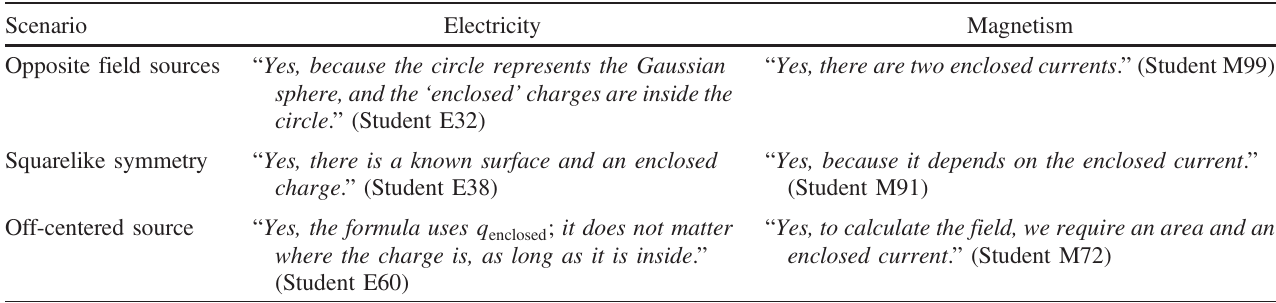
TABLE V. Examples of students ’ reasoning in the category enclosed field source for each scenario. Scenario Electricity Opposite field sources